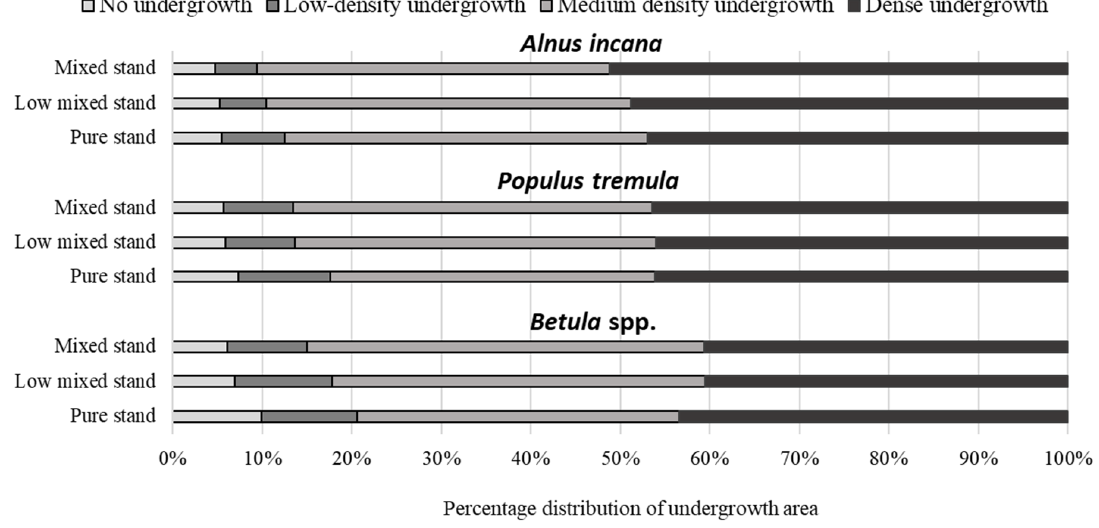
Figure 4. Percentage distribution of the undergrowth species areas, given for different undergrowth density categories (no undergrowth, low density – undergrowth species occupy less than 30%, medium density – 31–60%, and dense undergrowth more than 60%) in the mixed (less than 65% of the dominant tree species), low mixed (66–85% of the dominant tree species), and pure (86–100% of the dominant tree species) stands.